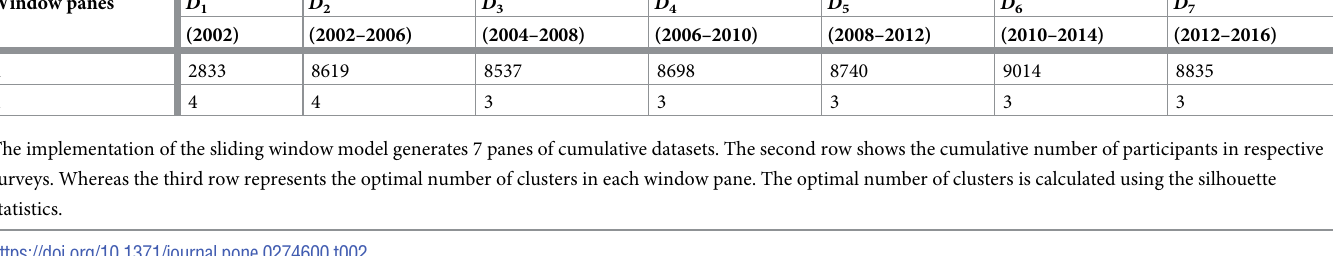
Table 2. Number of participants and optimal number of clusters. Window panes